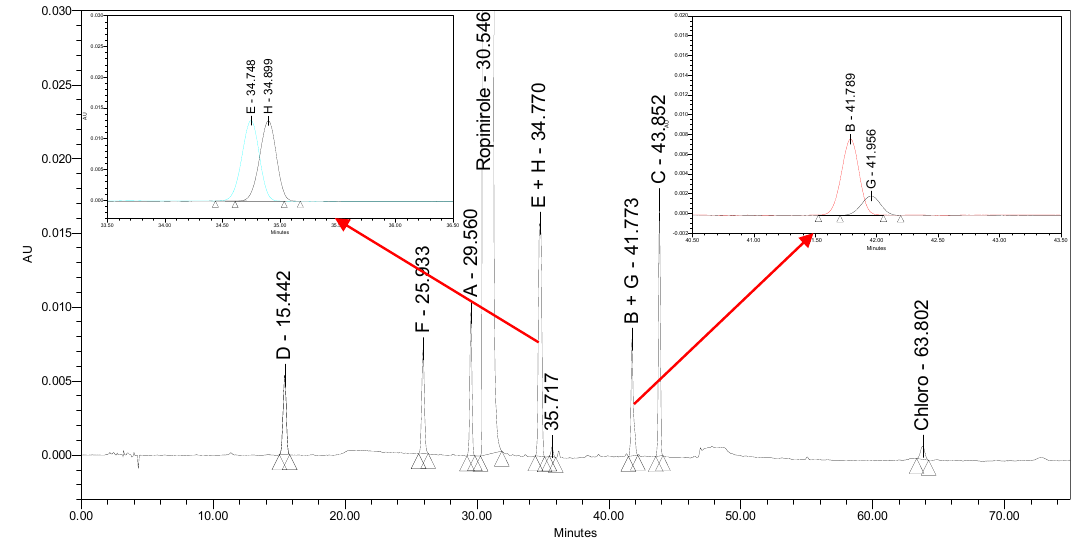
Figure 2. A chromatogram of ropinirole hydrochloride spiked with Ph. Eur. impurities A–H and chloro impurity obtained using the Ph. Eur. method. The co-elution between E and H is presented in the upper left corner, the co-elution between B and G is presented in the upper right corner.